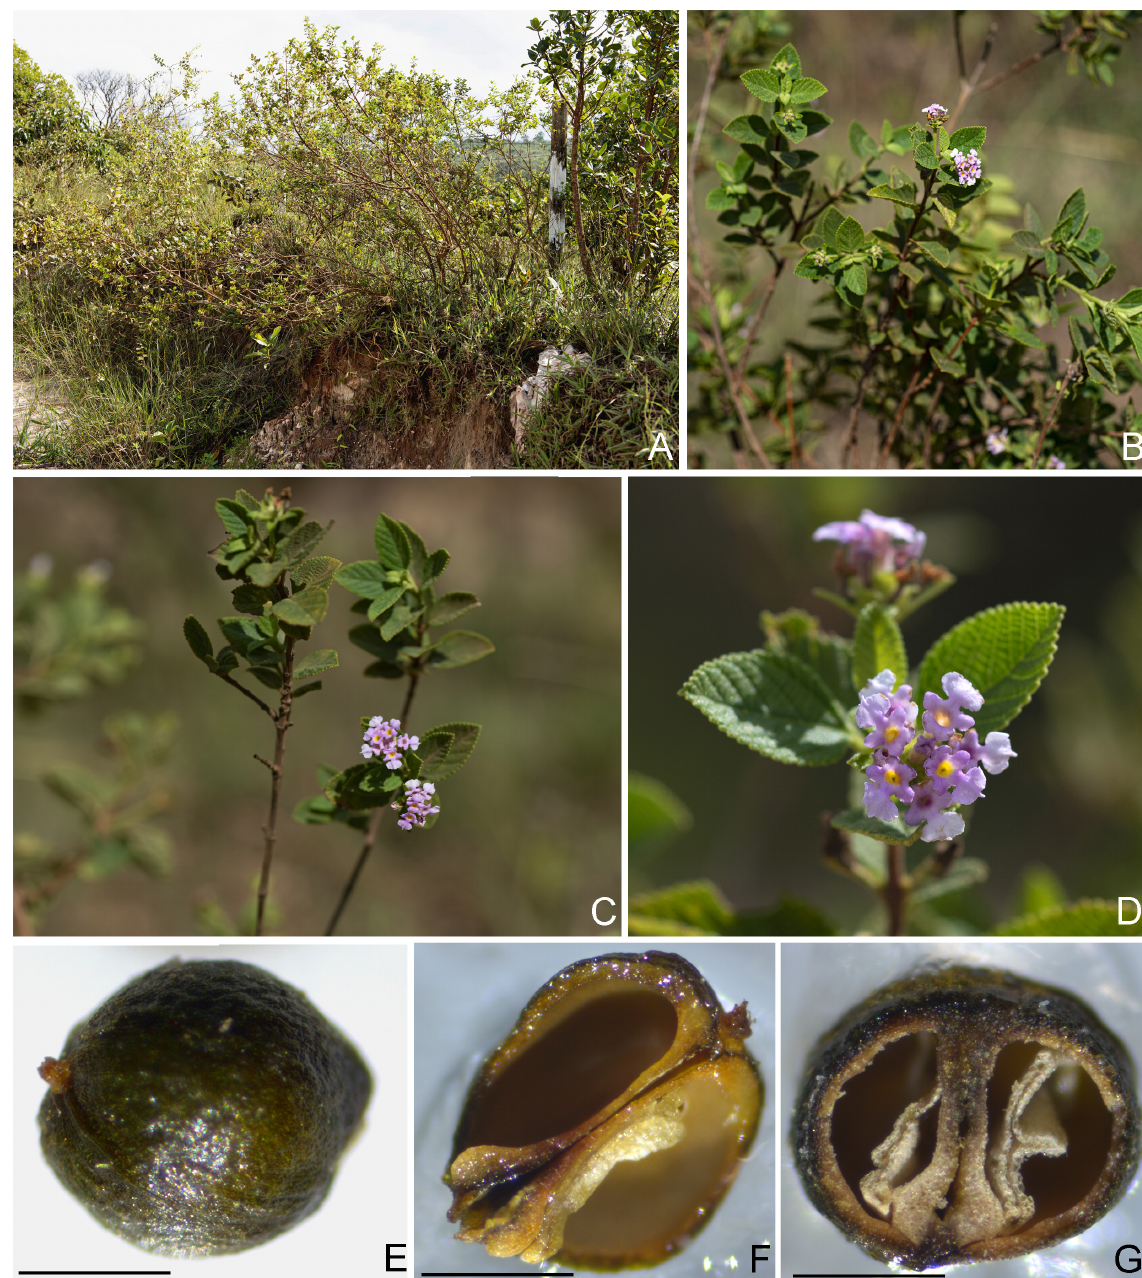
Fig. 1. Lippia raoniana P.H.Cardoso & Salimena sp. nov. A . Habit. B–C . Branch with inflorescence. D . Inflorescence frontal view. E-G . Drupaceous fruit. E . Overview. F . Longitudinal section showing two pyrenes. G . Cross section showing two pyrenes and seeds. Scale bars: E–G = 1 mm. Photos: A–D by Pedro Henrique Nobre; E–G by Nádia Silvia